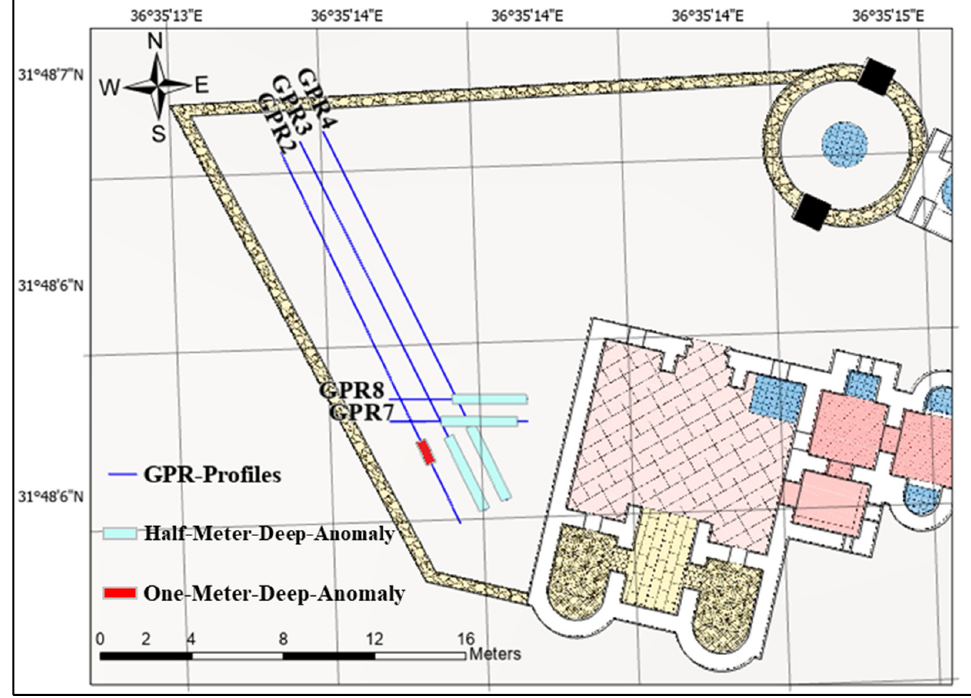
Figure 17. The detected GPR anomalies (basically walls) along GPR profiles.